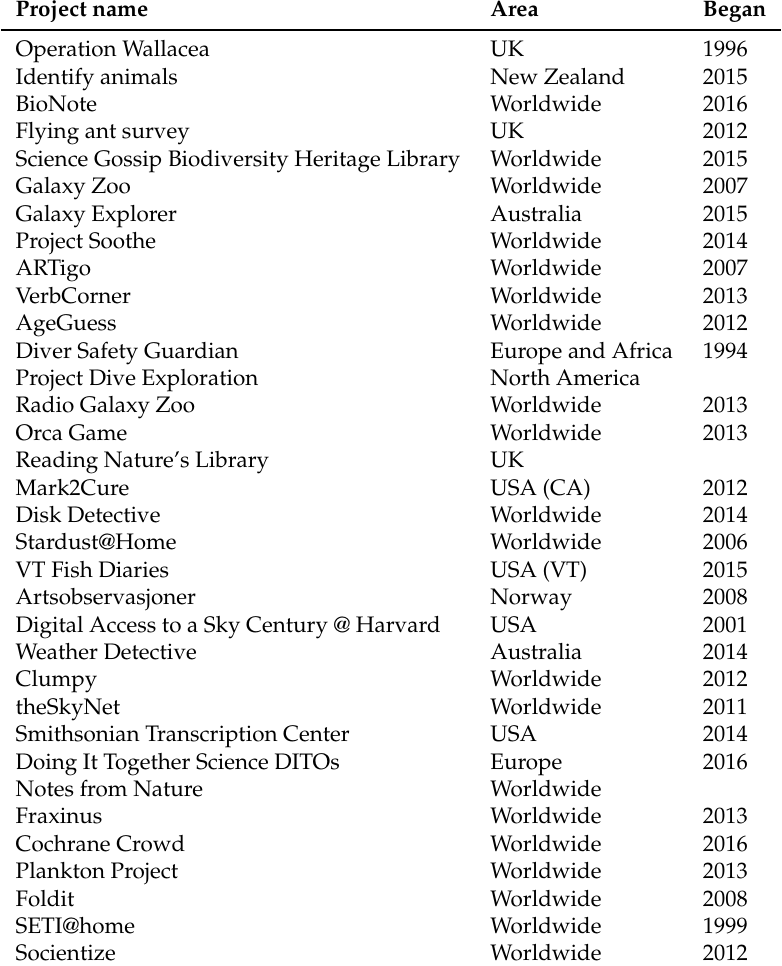
Table A3. List of discarded